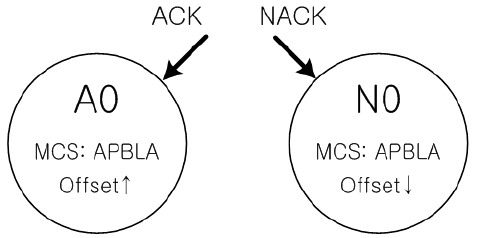
Figure 9. State diagram of the basic adaptive preamble-based link adaptation (APBLA).